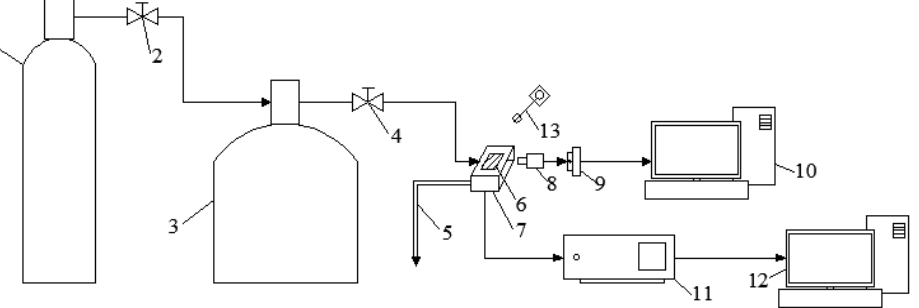
Figure 1. Experimental system. 1. Nitrogen gas bottle; 2. Intake valve; 3. Liquid nitrogen tank; 4. Inlet valve; 5. Outlet tube; 6. Experimental cold plate; 7. Tin box; 8. Microscope; 9. Camera; 10. Com-